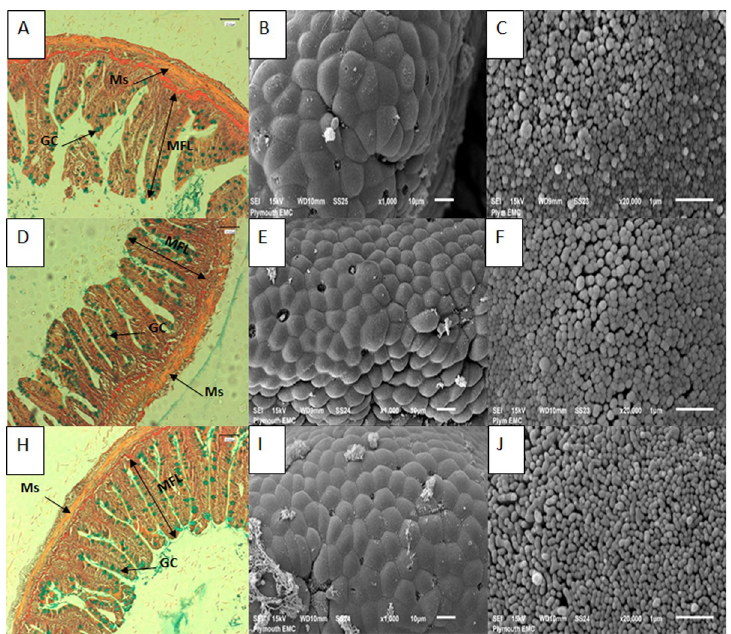
Fig 1. Photomicrographs and scanning electron micrographs of posterior intestine of rainbow trout indicating no signs of damage to tissues when fed with experimental and control diets. Images A-C represent control fed fish, A) cross section of intestine with AB-vG staining (x40 objective, scale bar is 100 μ m), arrows indicate different structures including: goblet cell (GC), muscularis (Ms) and mucosal fold length (MFL); B) scanning electron micrograph showing section of posterior intestine (scale bar is 10 μ m); C) scanning electron micrograph of microvilli of intestine (scale bar is 1 μ m). Images D-F represent fish fed MsYF continuously; Images H-J represent fish fed MsYF pulsed with control every 2 weeks.